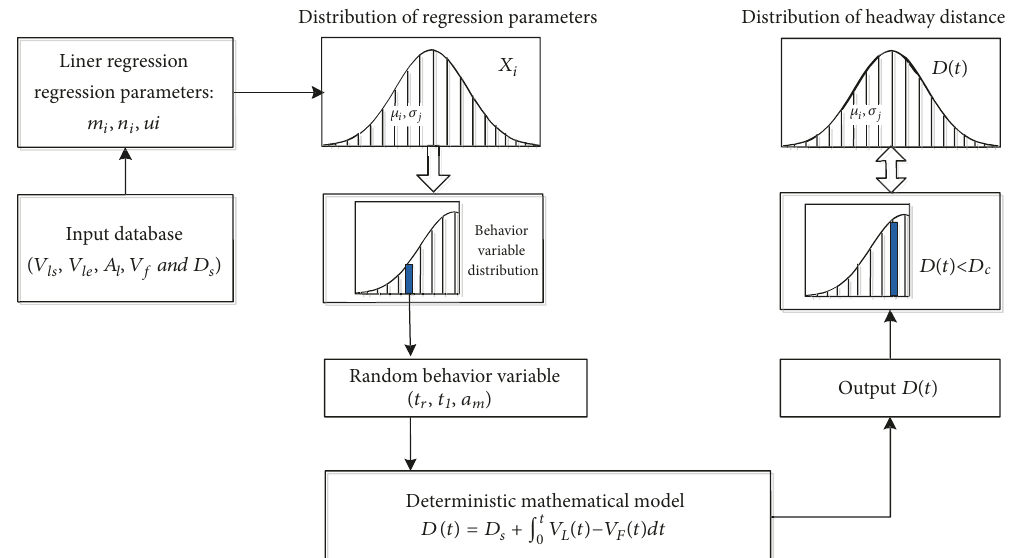
Figure 7: General schematic of rear-end collision risk